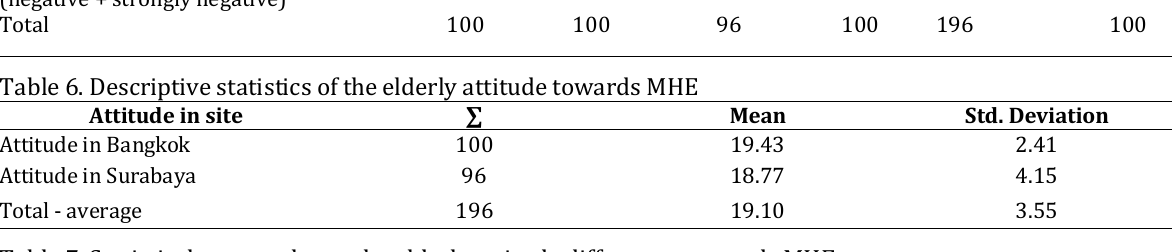
Table 7. Statistical test results on the elderly attitude differences towards MHE for Equality of Attitude